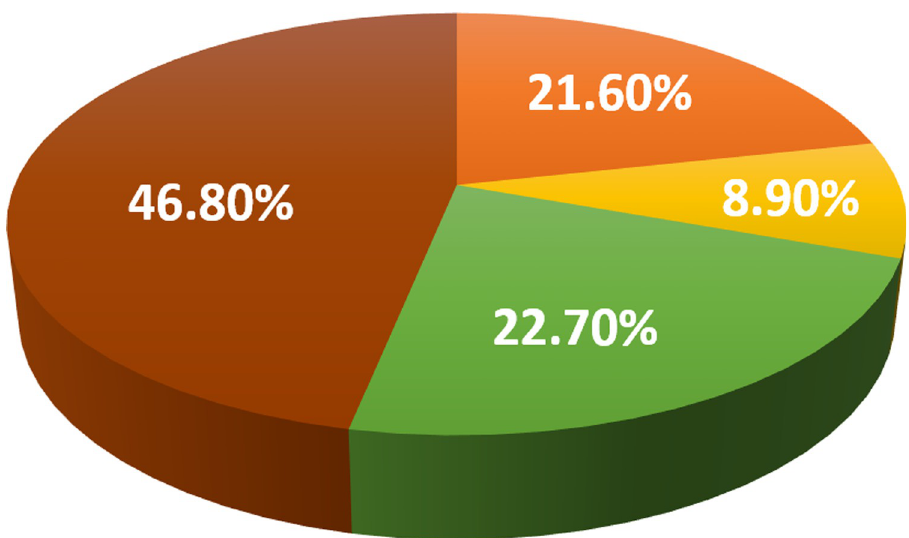
Fig 4. Antibody detection percentages for cELISA. Positive samples to T . equi (orange). Positive samples to B . caballi (yellow). Double-negative (green). Double-positive (brown).